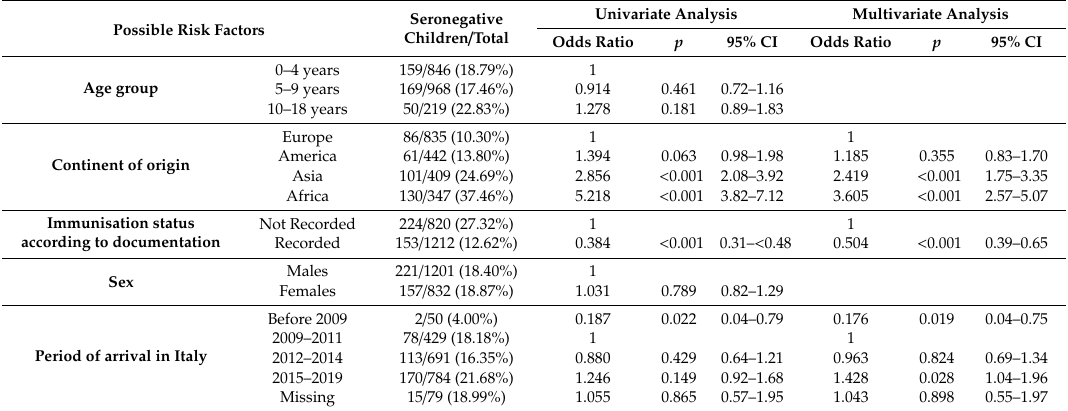
Table A8. Univariate and multivariate analyses for factors associated with seronegativity for tetanus.